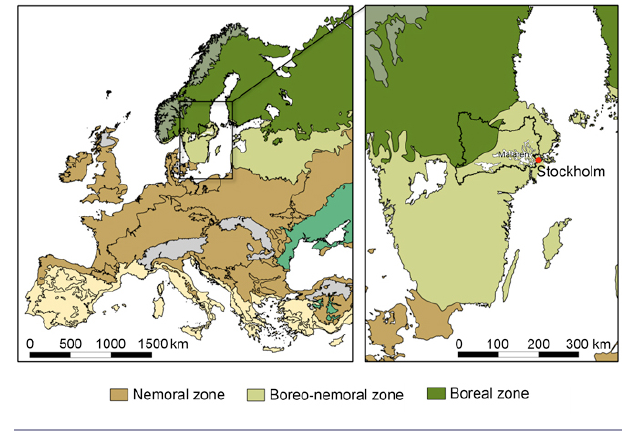
Fig. 1 . Location of the study area, the Norrström drainage basin (NDB), in south-central